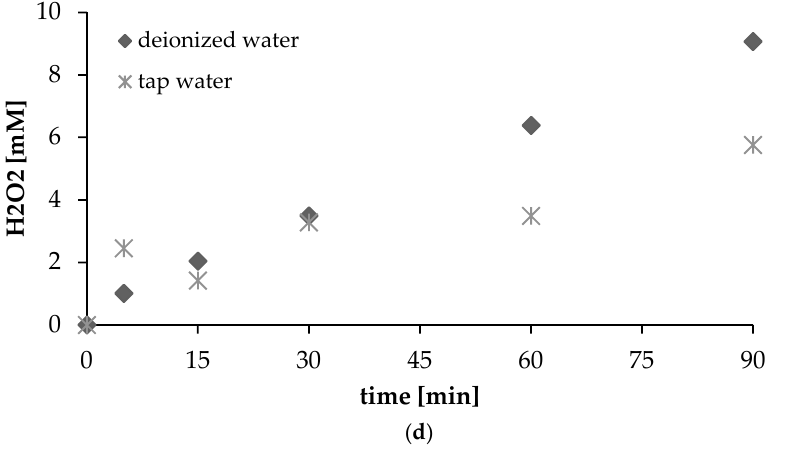
Figure 4. ( a ) Formation of H 2 O 2 with the effect of added H 2 O 2 (pH = 7, intensity of ultrasonic irradiation = 4.3 W/cm 2 ); ( b ) formation of H 2 O 2 with the effect of added dibutyl phthalate (DBP) (pH = 7, intensity of ultrasonic irradiation = 4.3 W/cm 2 ); ( c ) formation of H 2 O 2 with the effect of added DBP + H 2 O 2 ; ( d ) the formation of H 2 O 2 in tap water and deionized water (pH = 7, intensity of ultrasonic irradiation =4.3 W/cm 2